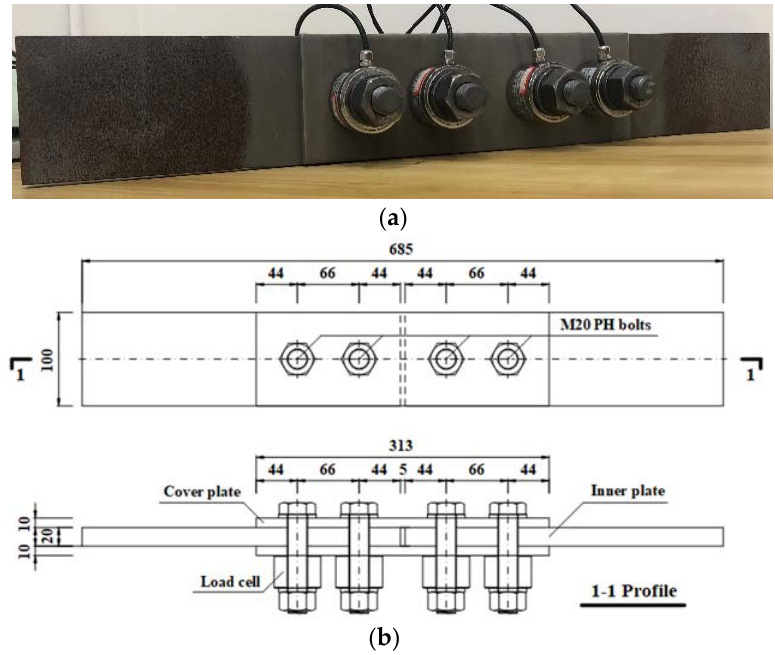
Figure 4. Slip factor test specimens. ( a ) Photo. ( b ) Schematic drawing.